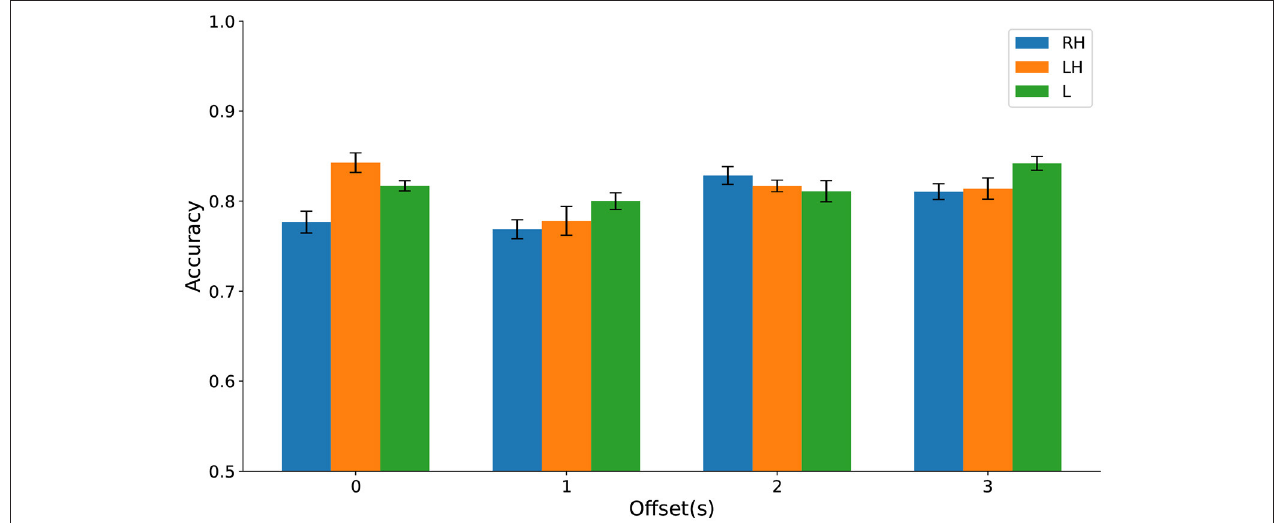
TABLE 2 | (Dataset 2) Classification performance on sPDP vs. sPNP, evaluated separately on Right Hand (RH), Left Hand (LH), and Leg (L) data.